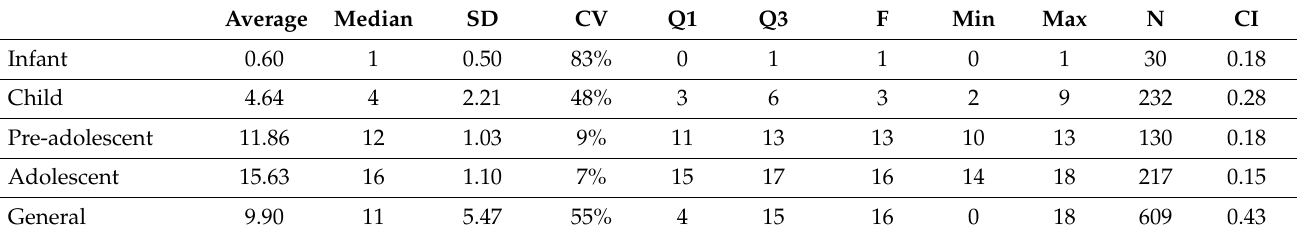
Table 2. Full description for age.